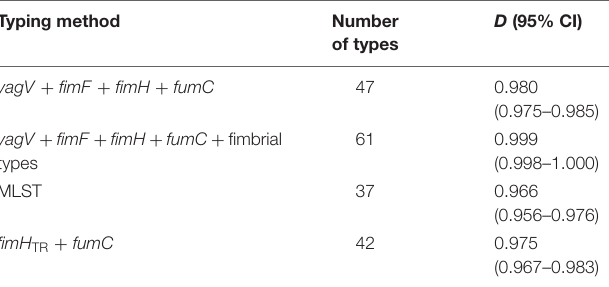
TABLE 3 | Numbers of types and D -values based on different typing methods of 67 clinical UPEC